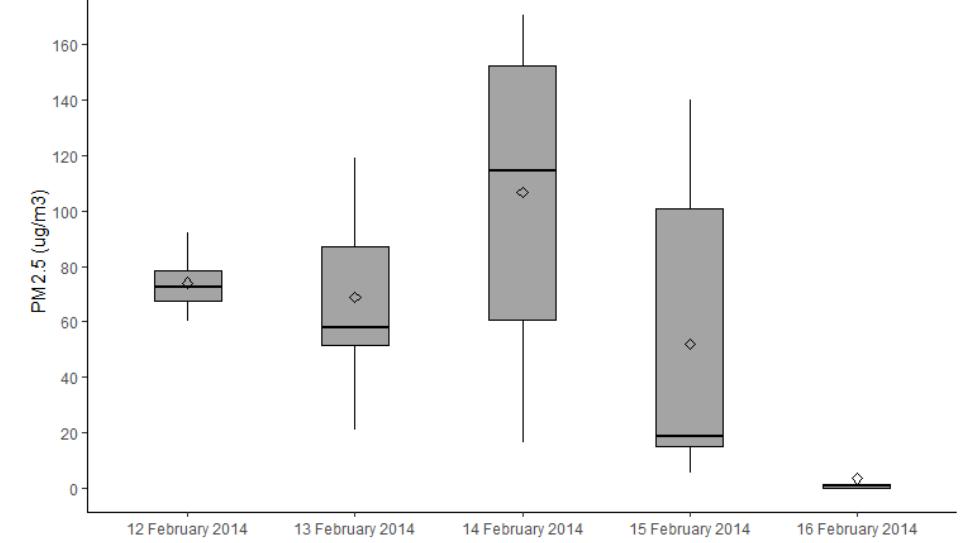
Figure 3. Boxplots showing median, quartiles and extreme concentrations of PM 2.5 (µg/m 3 ) as measured on the day’s health assessments were conducted in Warburton in 2014. Note that wildfires only occurred near Warburton during this study period.